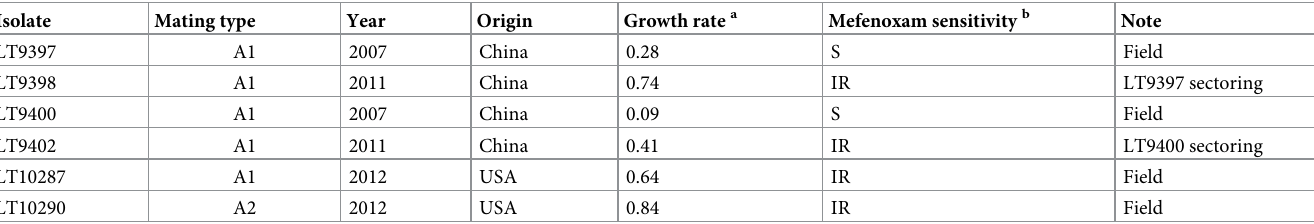
Table 2. Summary of Phytophthora capsici parental isolates used for monitoring mefenoxam sensitivity in zoospore progeny.